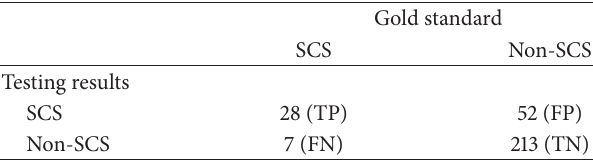
Table 6: Evaluation about SCS.